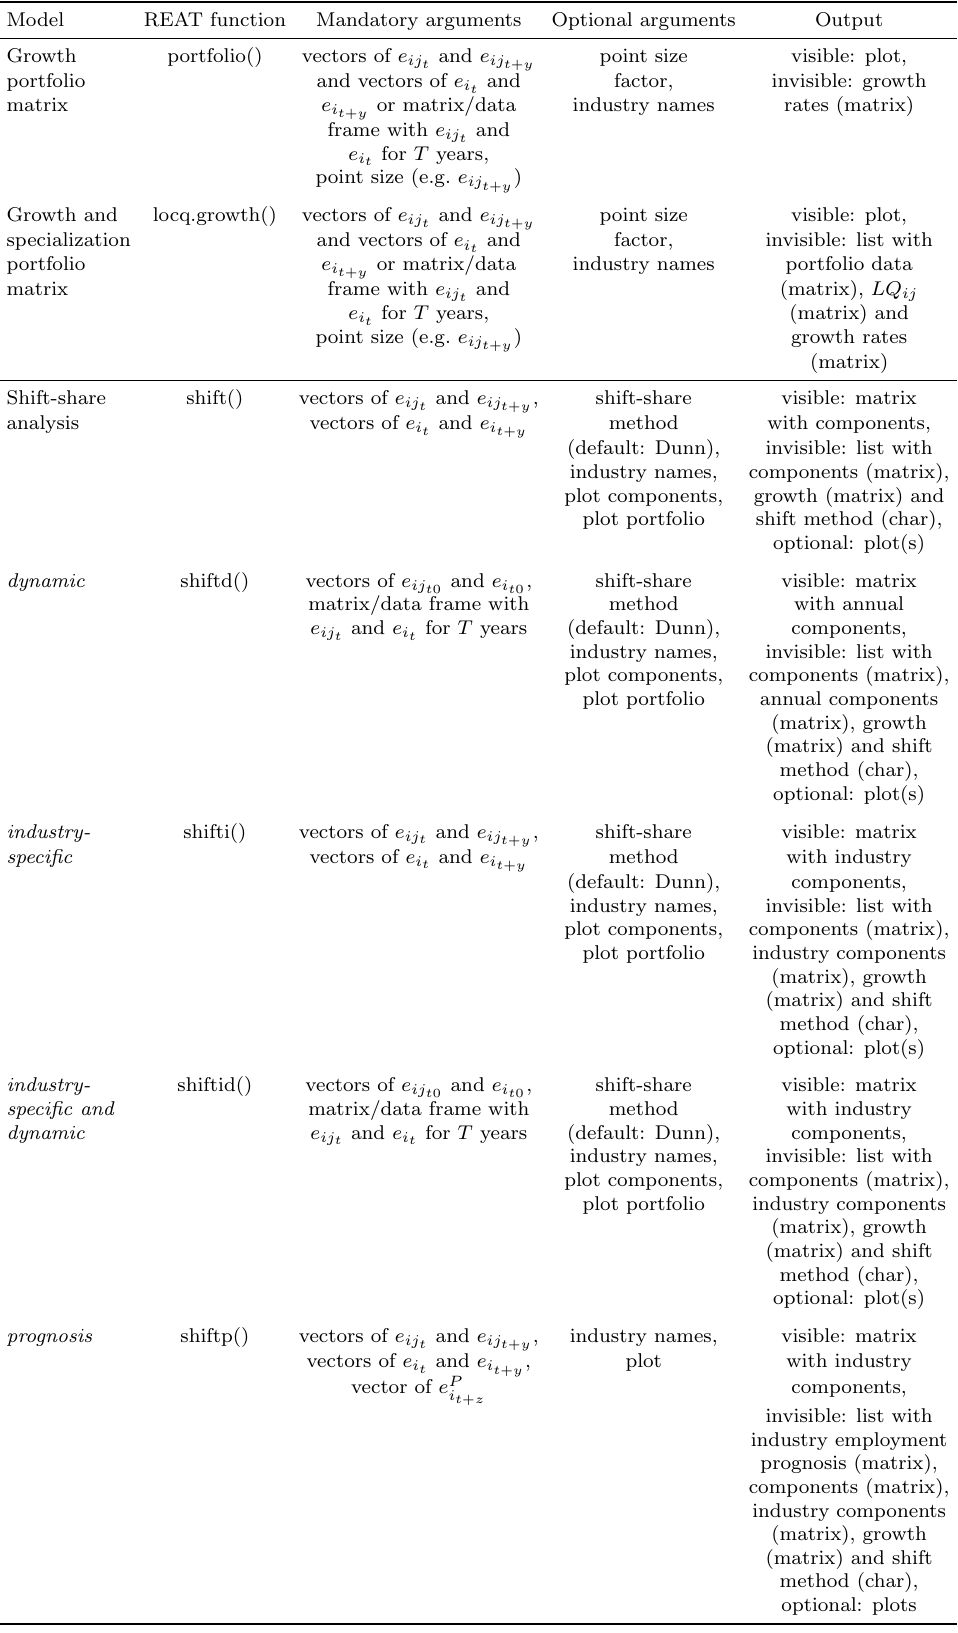
Table 14: REAT functions for analyzing regional